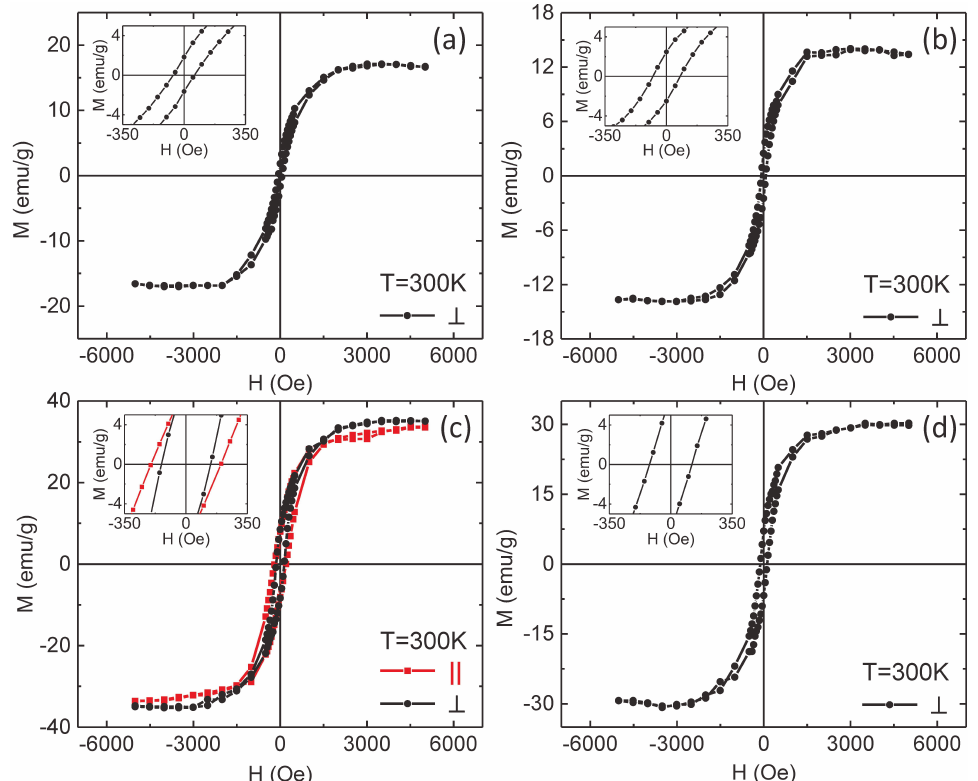
Figure 6. Hysteresis loops of samples S1 ( a ), S2 ( b ), S3 ( c ) and S4 ( d ), recorded at 300 K with the magnetic field applied perpendicular (black lines with dots) and parallel (red line with squares) to the NTs axis. The latter is shown only for S3. The insets represent corresponding closed-up magnifications around the coordinate system’s origin, showing the magnetic coercivity within the prepared